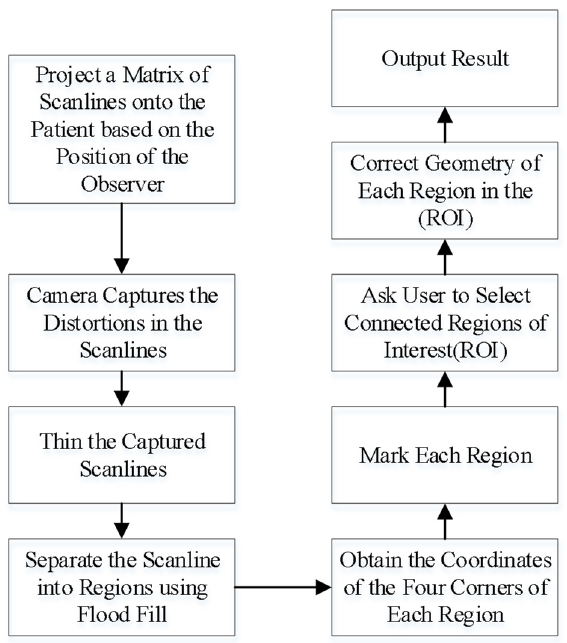
Figure 8. Flowchart of the process of projecting image onto the skin surface of a patient.